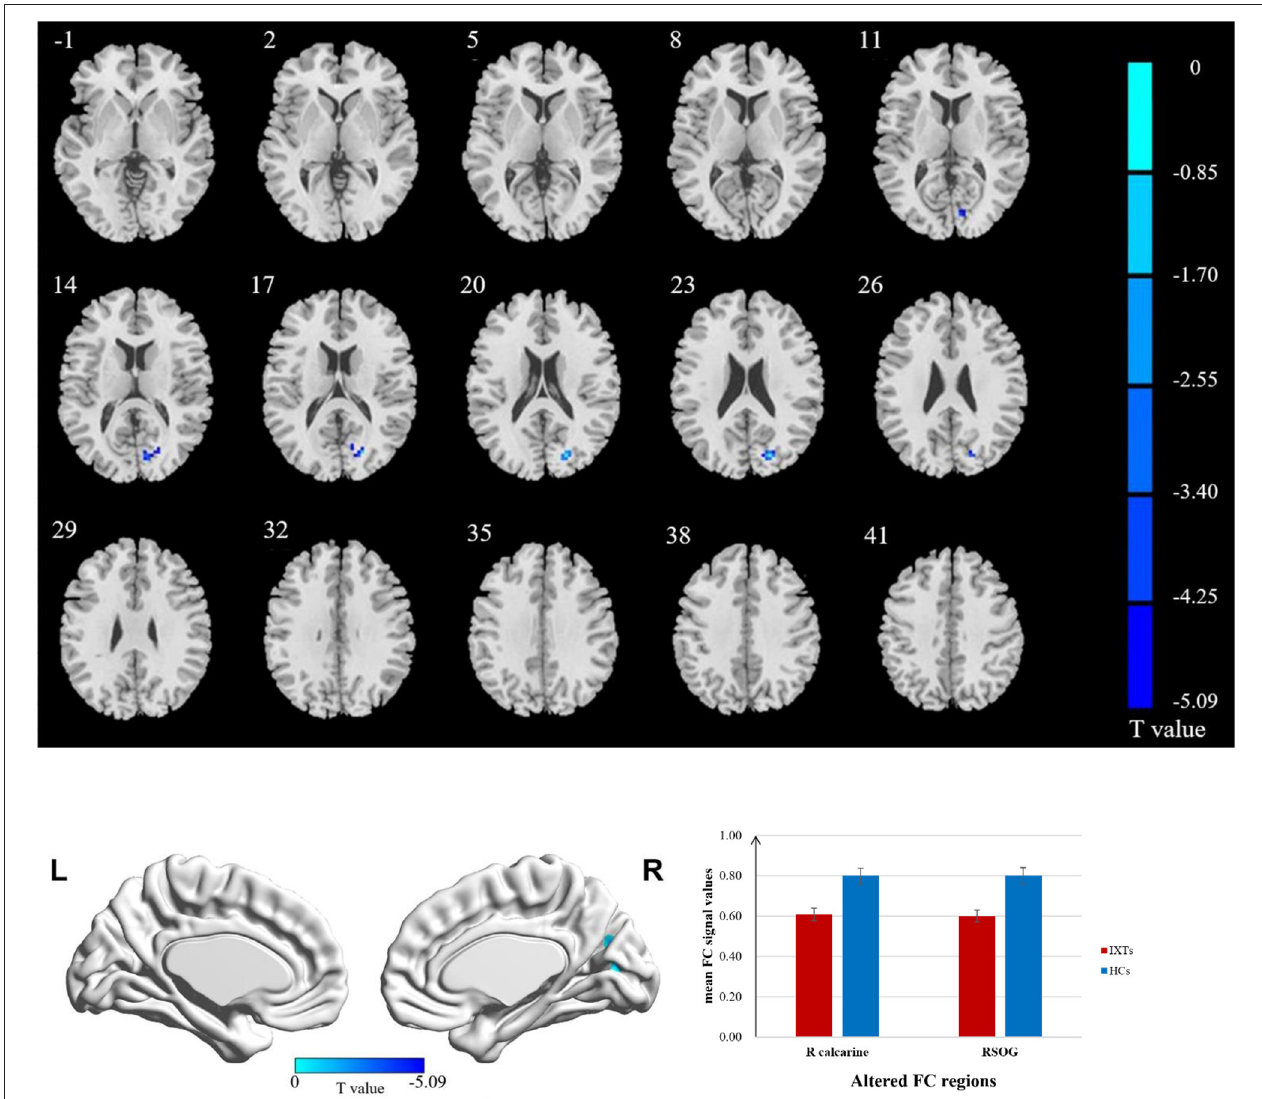
FIGURE 1 | Brain regions demonstrate statistically significant differences between two groups in terms of FC in the right BA17 (GRF corrected, P < 0.05). Decreased FC values were observed in the right calcarine and right superior occipital gyrus (SOG). The details of the negative regions can be found in Table 2 . IXTs, Intermittent exotropia; HCs, Healthy controls; BA, Brodmann area; FC, Functional